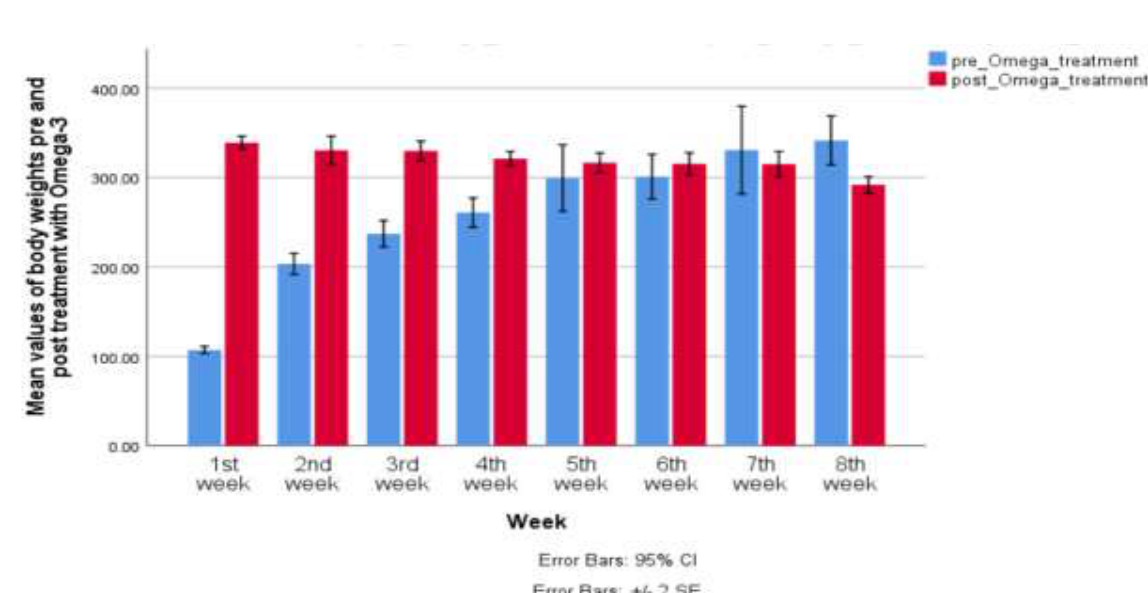
Figure 5. Demonstrate the effect of pre- and post-treatment with omega-3 (1ml/day) on body weights in male Wistar.